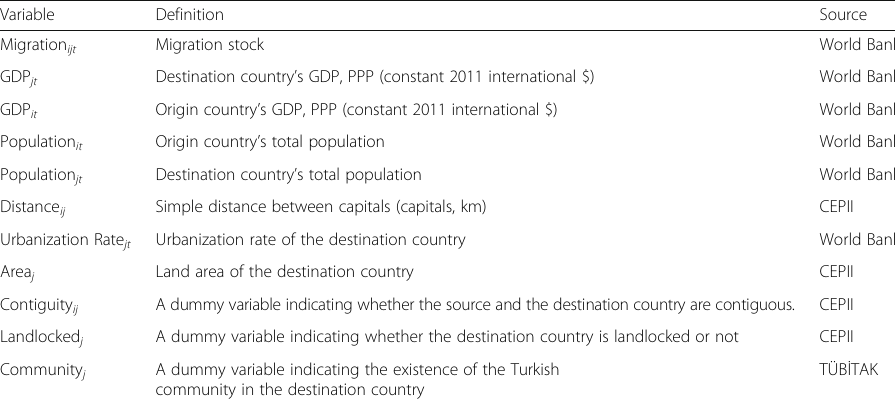
Table 7 Variable definitions, data definitions and